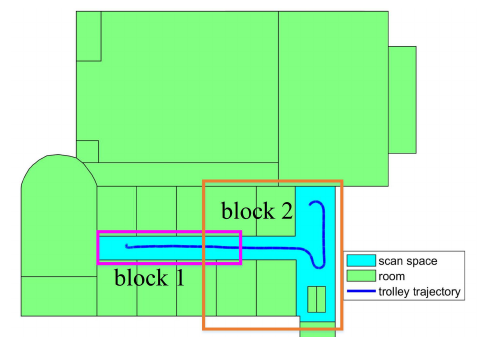
Figure 3. The point cloud of the experimentation scene. Points from left sensor are in , from right are in , and added virtual points are in .